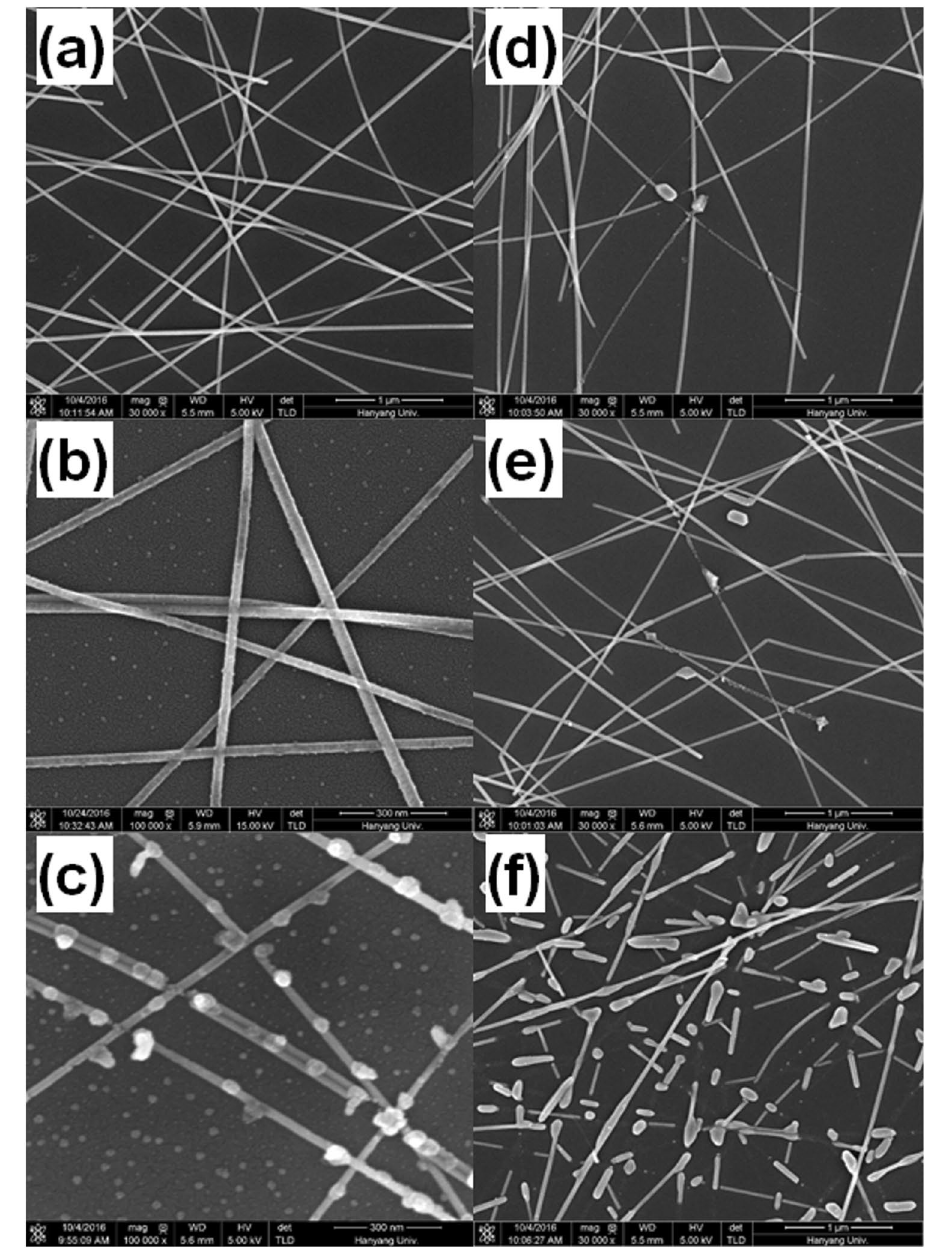
Figure 3. Scanning electron microscopy images of the ( a ) pristine Ag NWs, the ( b ) Ag NWs UV/O 3 -treated for 30 min, the ( c ) Ag NWs UV/O 3 -treated for 60 min, and the Ag NWs thermally treated at ( d ) 160, ( e ) 190, and ( f ) 210 °C for 10 min on Si